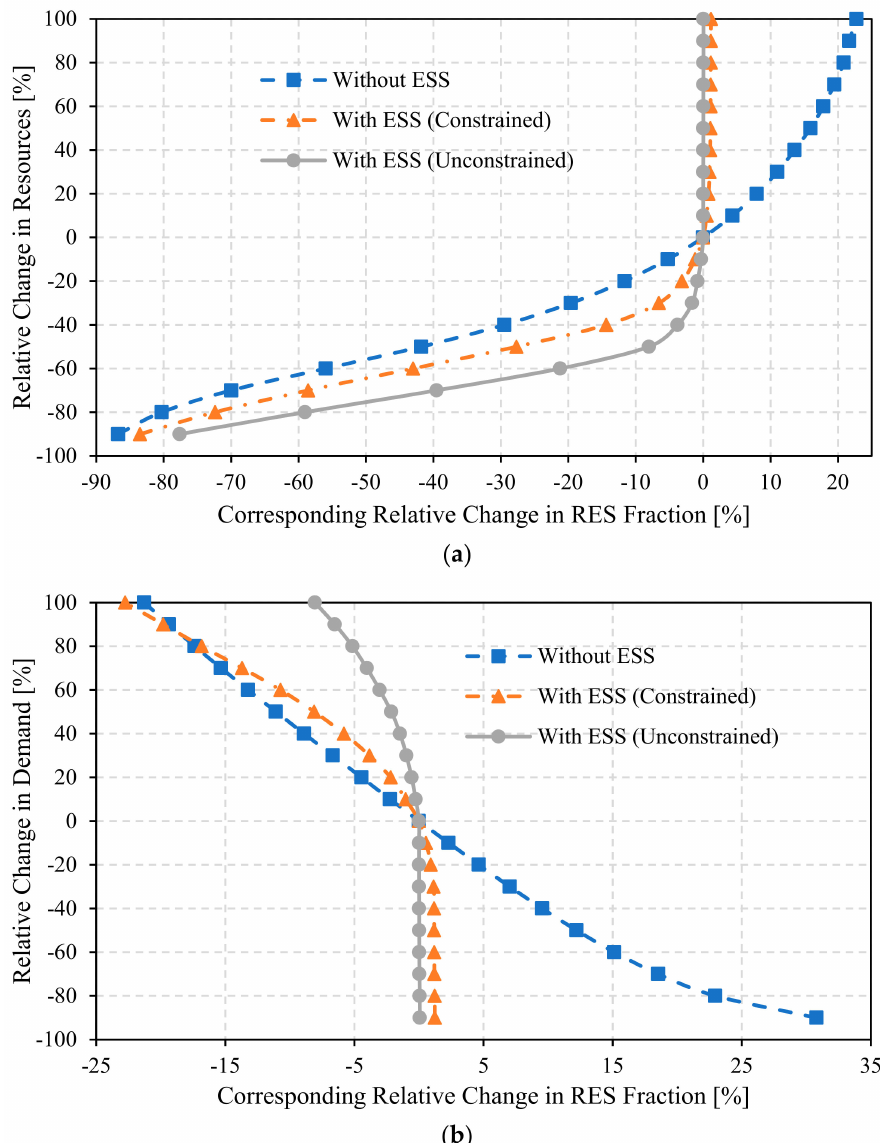
Figure 9. The sensitivity of the RES fraction to the variations in the: ( a ) Solar and wind resources and ( b )